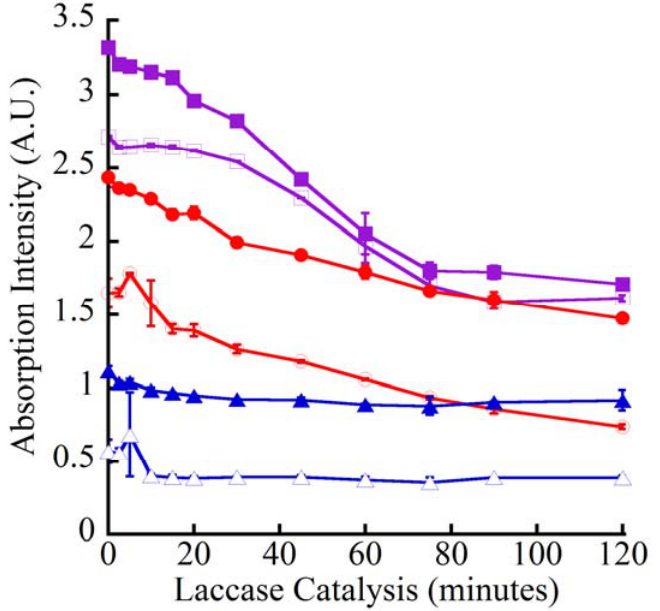
Figure 2. Laccase kinetic (260 nm) and pseudo- kinetic (290 nm) oxidation of CA. Laccase (0.1  g/mL) was used to oxidize 500  M CA in 100  L of pH 4.5 buffer using UV- transparent 96-well microplate. Absorbance decrease from identical reactions was measured at 260 nm (open symbols) for the indicated time periods. Pseudo -kinetic reactions were stopped with base (100 mM NaOH) and absorbance decreases were measured at 290 nm (closed symbols). The CA samples analyzed were from Alfa Aesar (open and closed triangles, blue tracings), Acros Organics (open and closed circles, red tracings) and Sigma-Aldrich (open and closed squares, purple